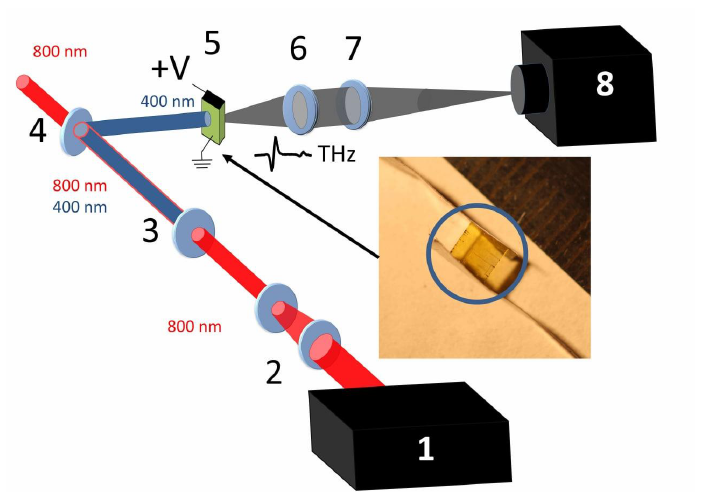
Figure 1. Experimental setup: 1—fs-laser; 2—telescope; 3—BBO crystal (SHG); 4—2nd harmonic (at 400 nm) selector; 5—diamond PCA; 6—PTFE lens (f = 6 cm); 7—PTFE lens (f = 10 cm); 8— Golay